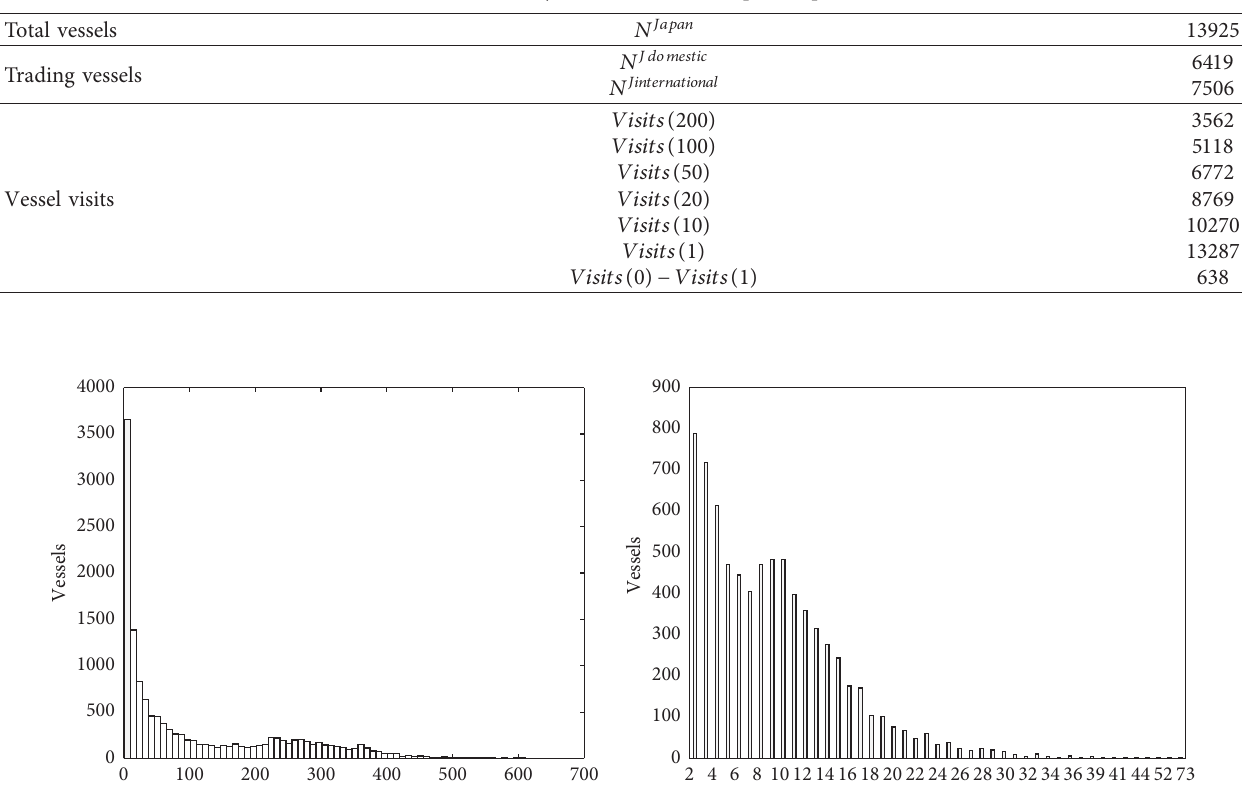
Table 2: Summary of vessel visits to Japanese ports.